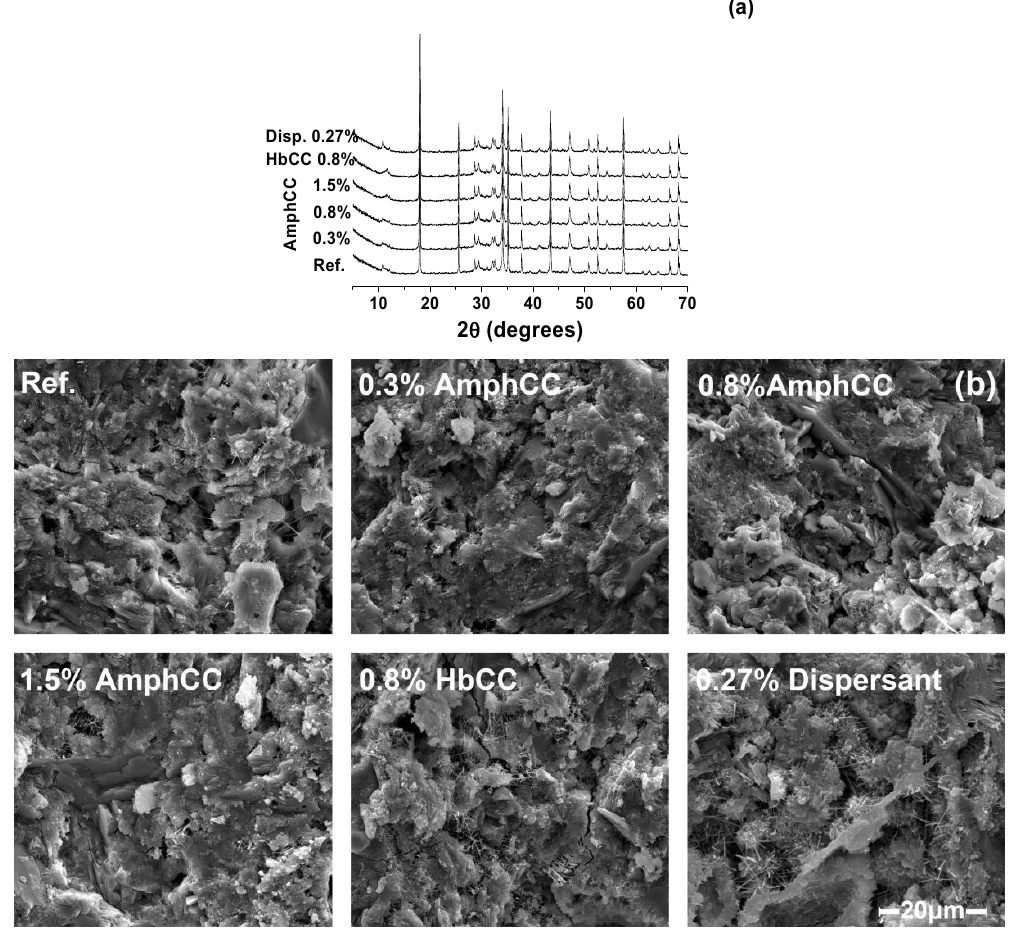
Table 5. Phase content of the paste samples from XRD calculation.